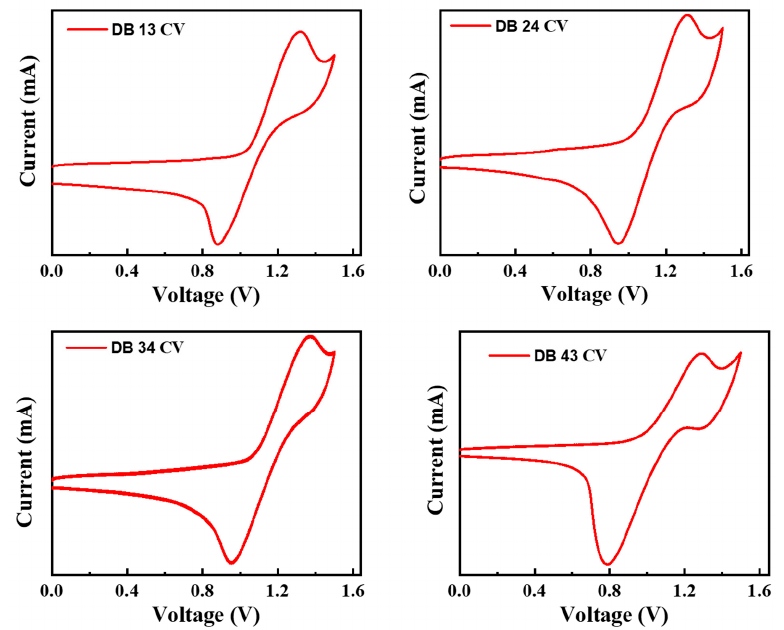
Figure 8. Cyclic voltammetry scans for calculation of HOMO levels of the compounds DB13, DB24, DB34 and DB43.